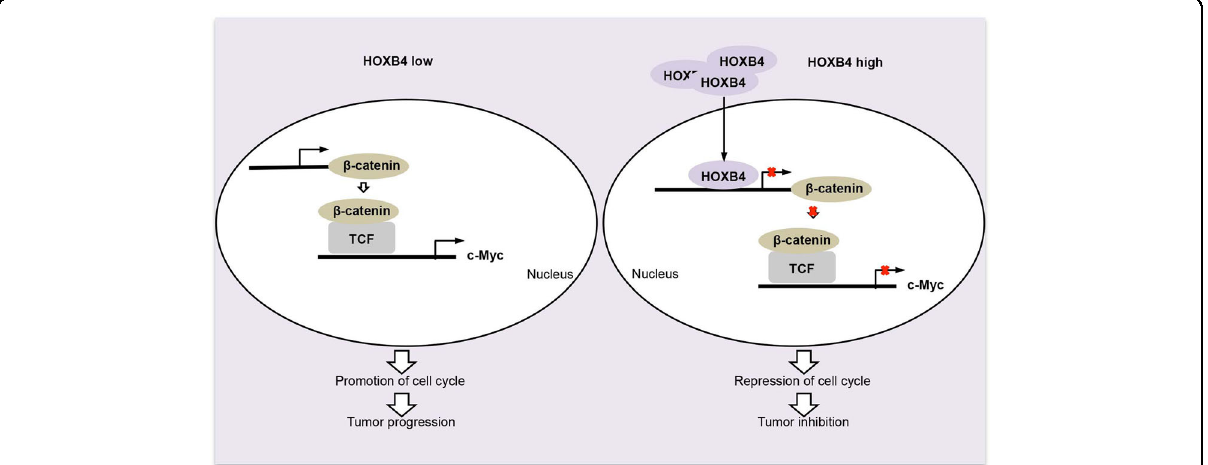
Fig. 7 A model of the HOXB4/ β -catenin/c-Myc in cervical cancer. In cervical cancer, loss of HOXB4 upregulated β -catenin and its downstream gene c-Myc, which contributed to the enhancement of the cell cycle and promoted tumor progression. In HOXB4-overexpressing cervical cancer cells, HOXB4 was accessed to the nucleus and transcriptionally repressed β -catenin expression, leading to impaired nuclear accumulation of β -catenin, which subsequently contributed to the inhibition of tumor